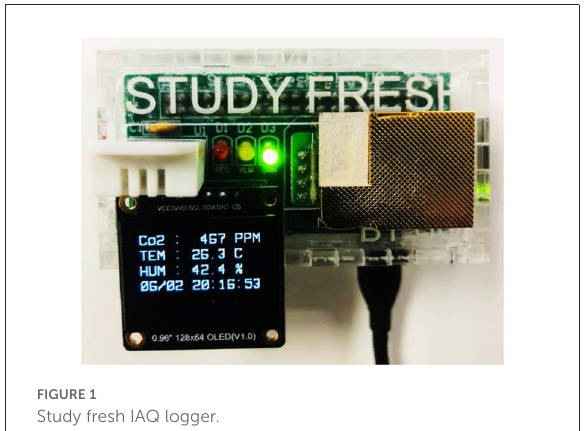
FIGURE1 Study fresh IAQ